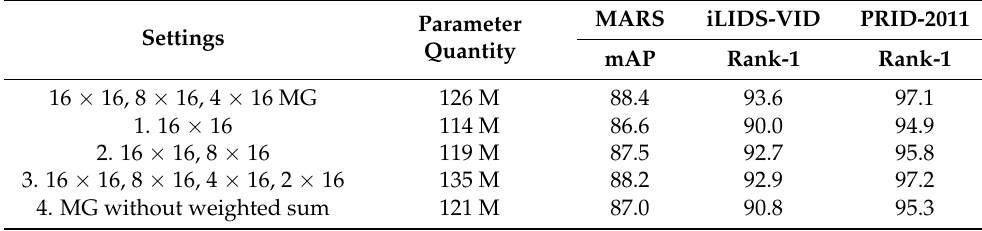
Table 3. The ablation experiment results of MG module.